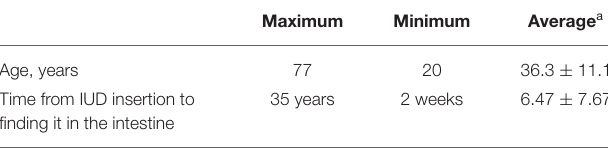
TABLE 1 | Demographics of patients in the included case series.